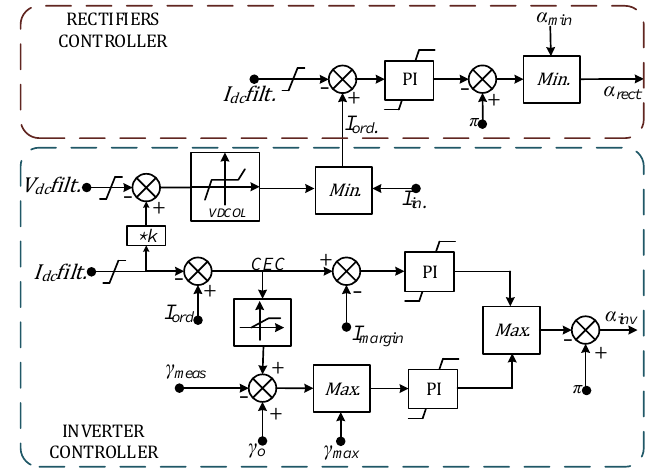
Figure 7. Current and voltage controller.